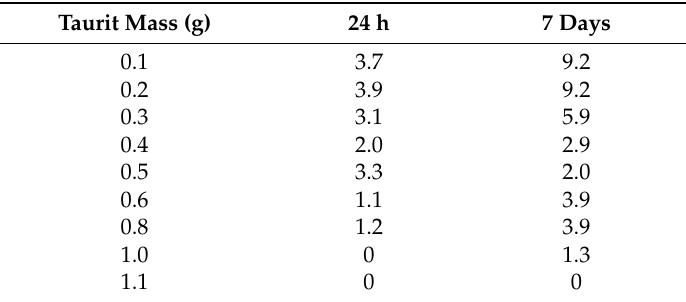
Table 4. Adsorbed sulfate mass (mg sulfate/mg Taurit) in %. Taurit Mass